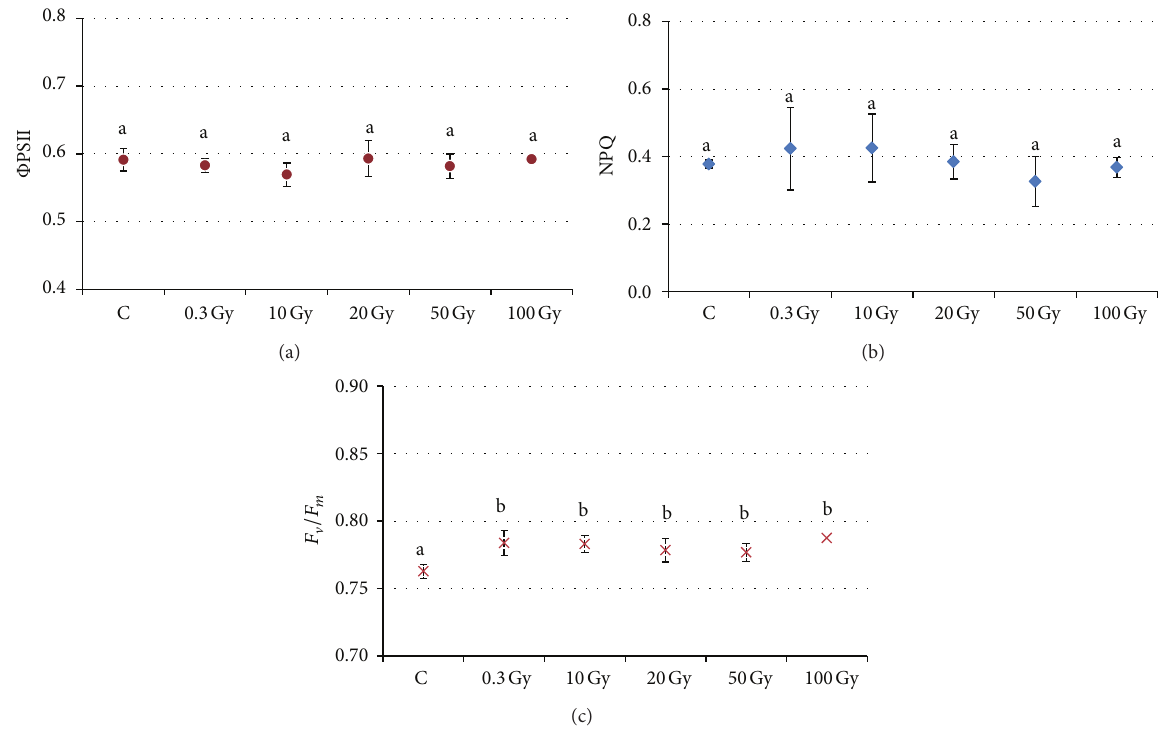
Figure 6: Quantum yield of PSII electron transport ( Φ PSII, a), nonphotochemical quenching (NPQ, b), and maximal PSII photochemical efficiency (Fv/Fm, c), in compound (CL) S. lycopersicum L. “Microtom” leaves of control and plants from seeds irradiated at different doses of X-rays. Mean values and standard deviations are shown ( 𝑛 = 5 ). Different letters correspond to significantly different values according to multiple comparison tests ( 𝑃 < 0.05 ).